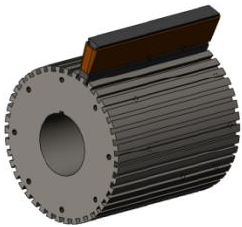
Figure 7. Connection diagram of single-tooth and core skeleton.